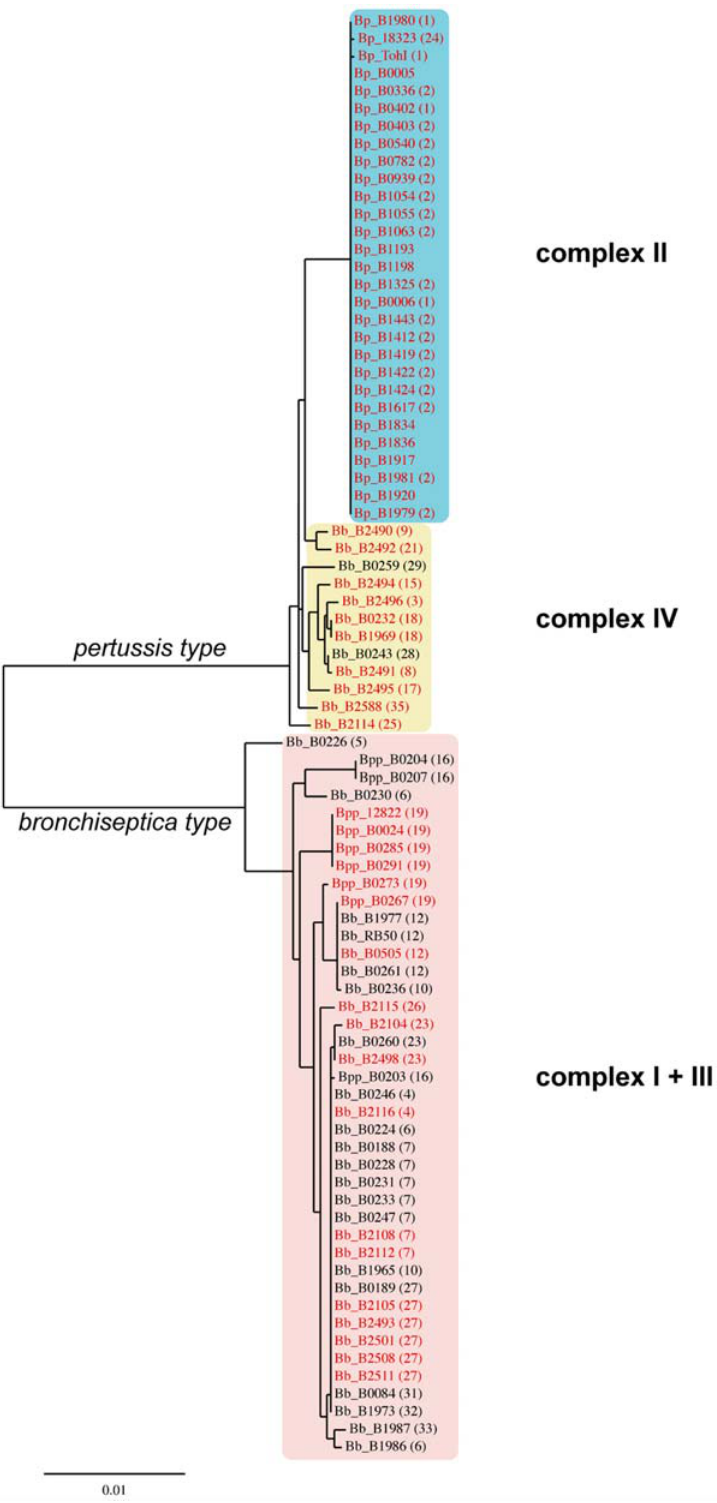
Figure 1. Phylogenetic tree based on the DNA sequences of bvgS . The lengths of the branches represent the phylogenetic distances. All human B. pertussis (Bp), B. bronchiseptica (Bb) and B. parapertussis (Bpp) isolates are shown in red. The major complexes identified in an earlier study [28] are boxed in colors, and the numbers in parentheses correspond to the sequence types defined in that study.